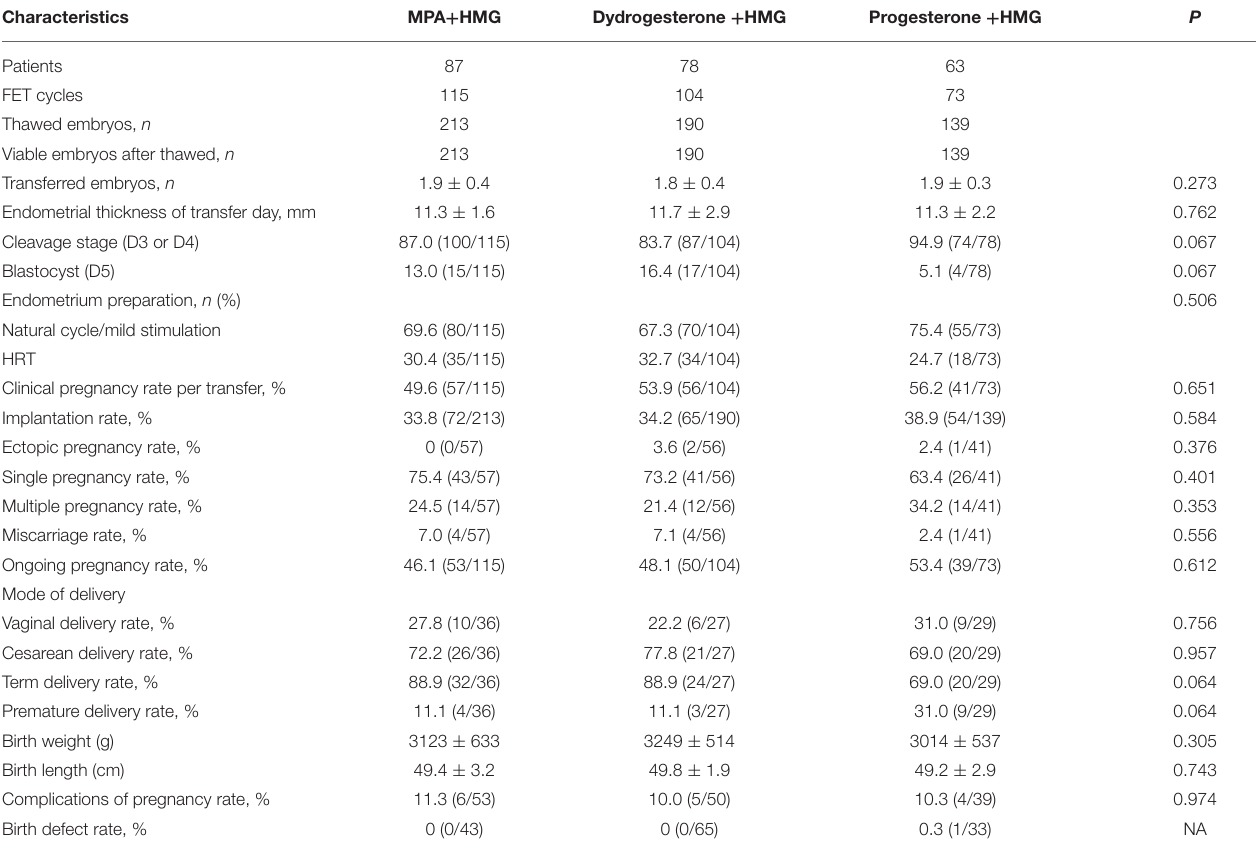
TABLE 3 | Pregnancy outcomes of frozen-thawed embryos. Characteristics